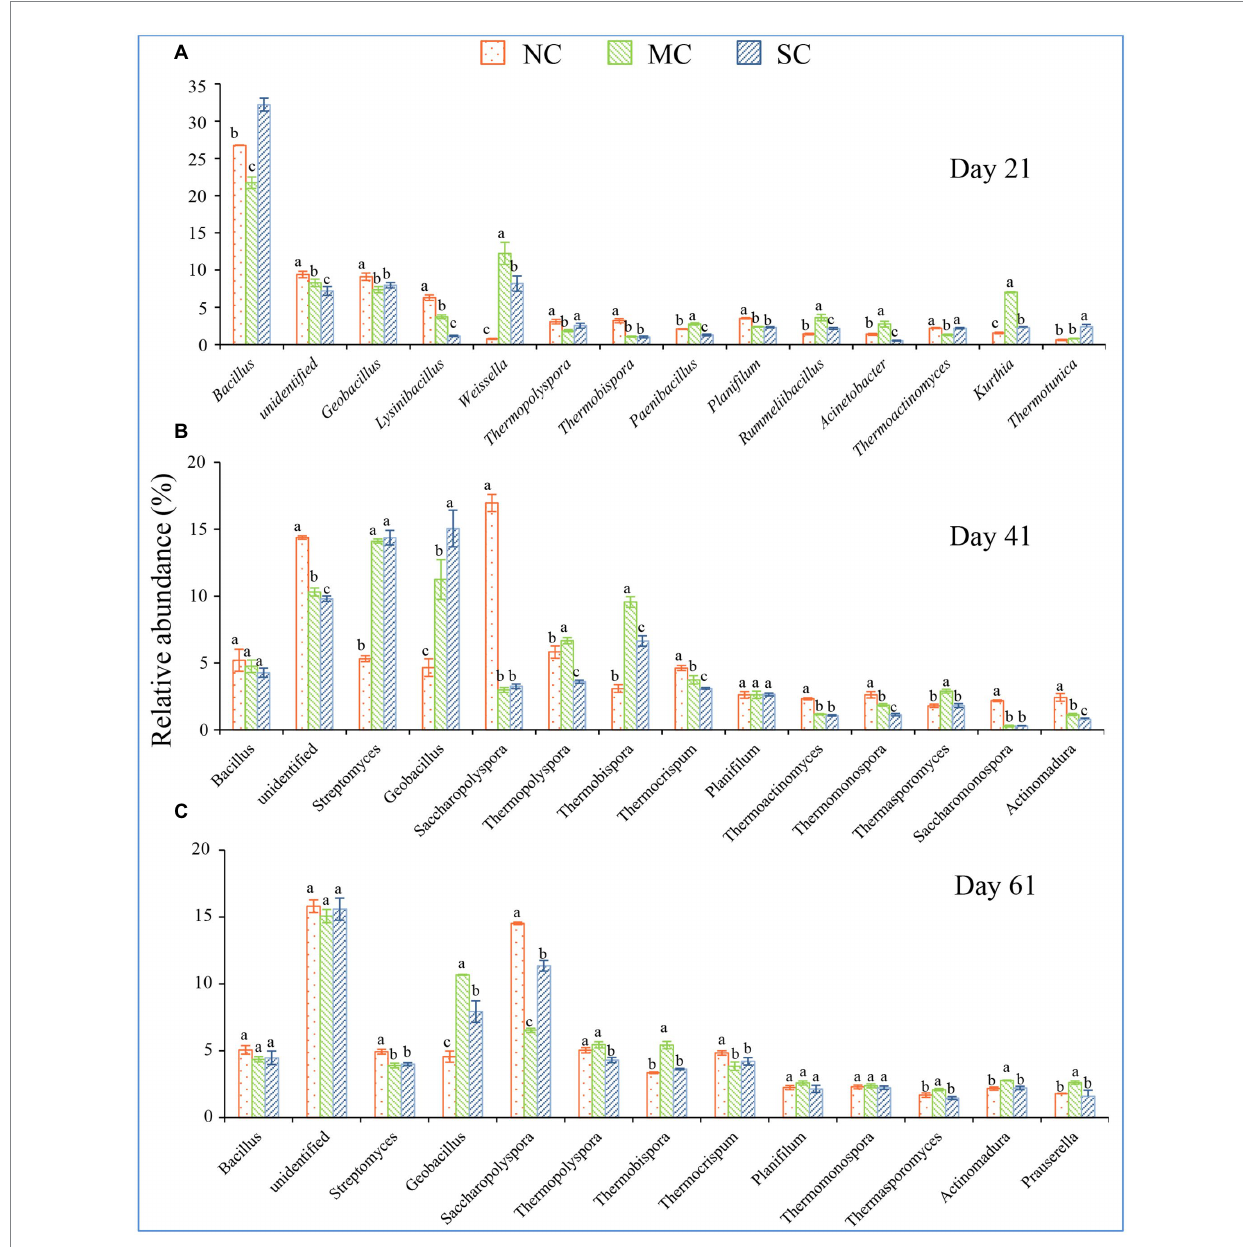
FIGURE 4 The dominant community changes in the different phases of the composting process. (A–C) shows the relative abundance of dominant genera on Days 21, 41, and 61, respectively. The error bars represent the standard deviations of the means. Different letters denote significant differences by ANOVA test ( p <